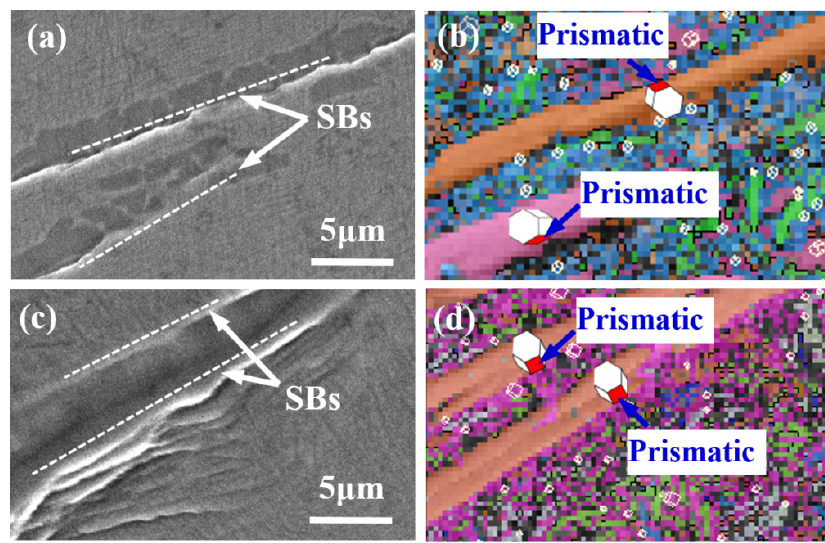
Figure 17. Examples of identification of activated slip systems on α L phase in lamellar microstruc- ture; ( a , b ) prismatic slips activate in two α L phase with SF values of 0.44 and 0.42, respectively; ( c , d ) prismatic slips activate in two α L phases with SF values of 0.43 and 0.45, respectively.